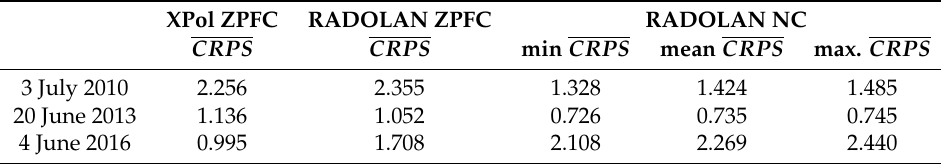
Table 7. Ensemble skill analysis for nowcast